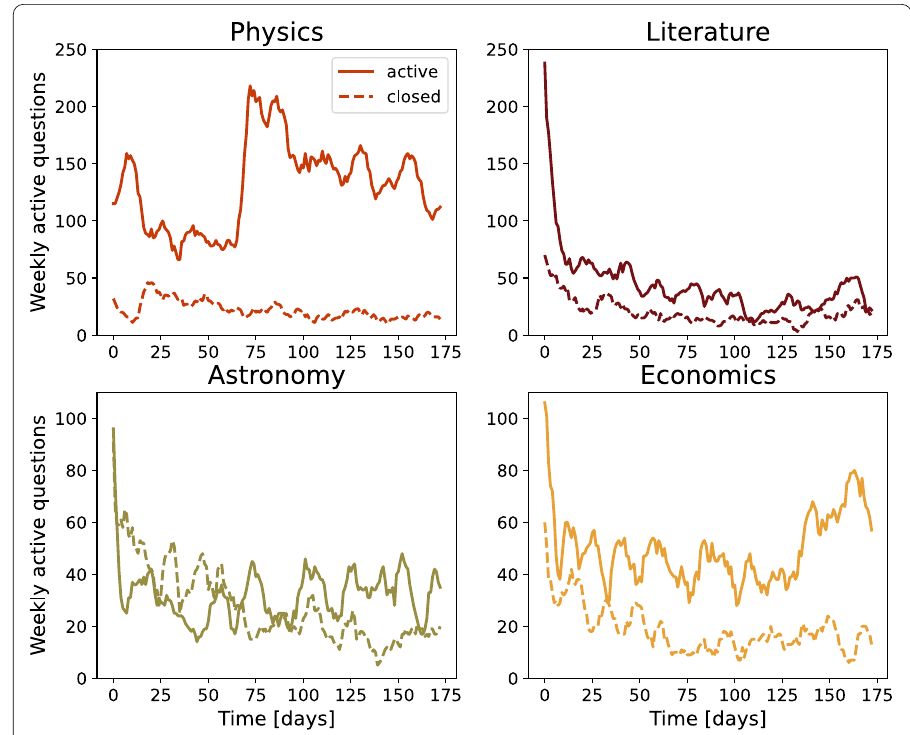
Figure 2 Variations in the number of active questions in SE communities. Number of active questions within 7 days sliding windows on the four pairs of Stack Exchange websites: Astronomy, Literature, Economics and Physics. Solid lines – active sites; dashed lines – closed